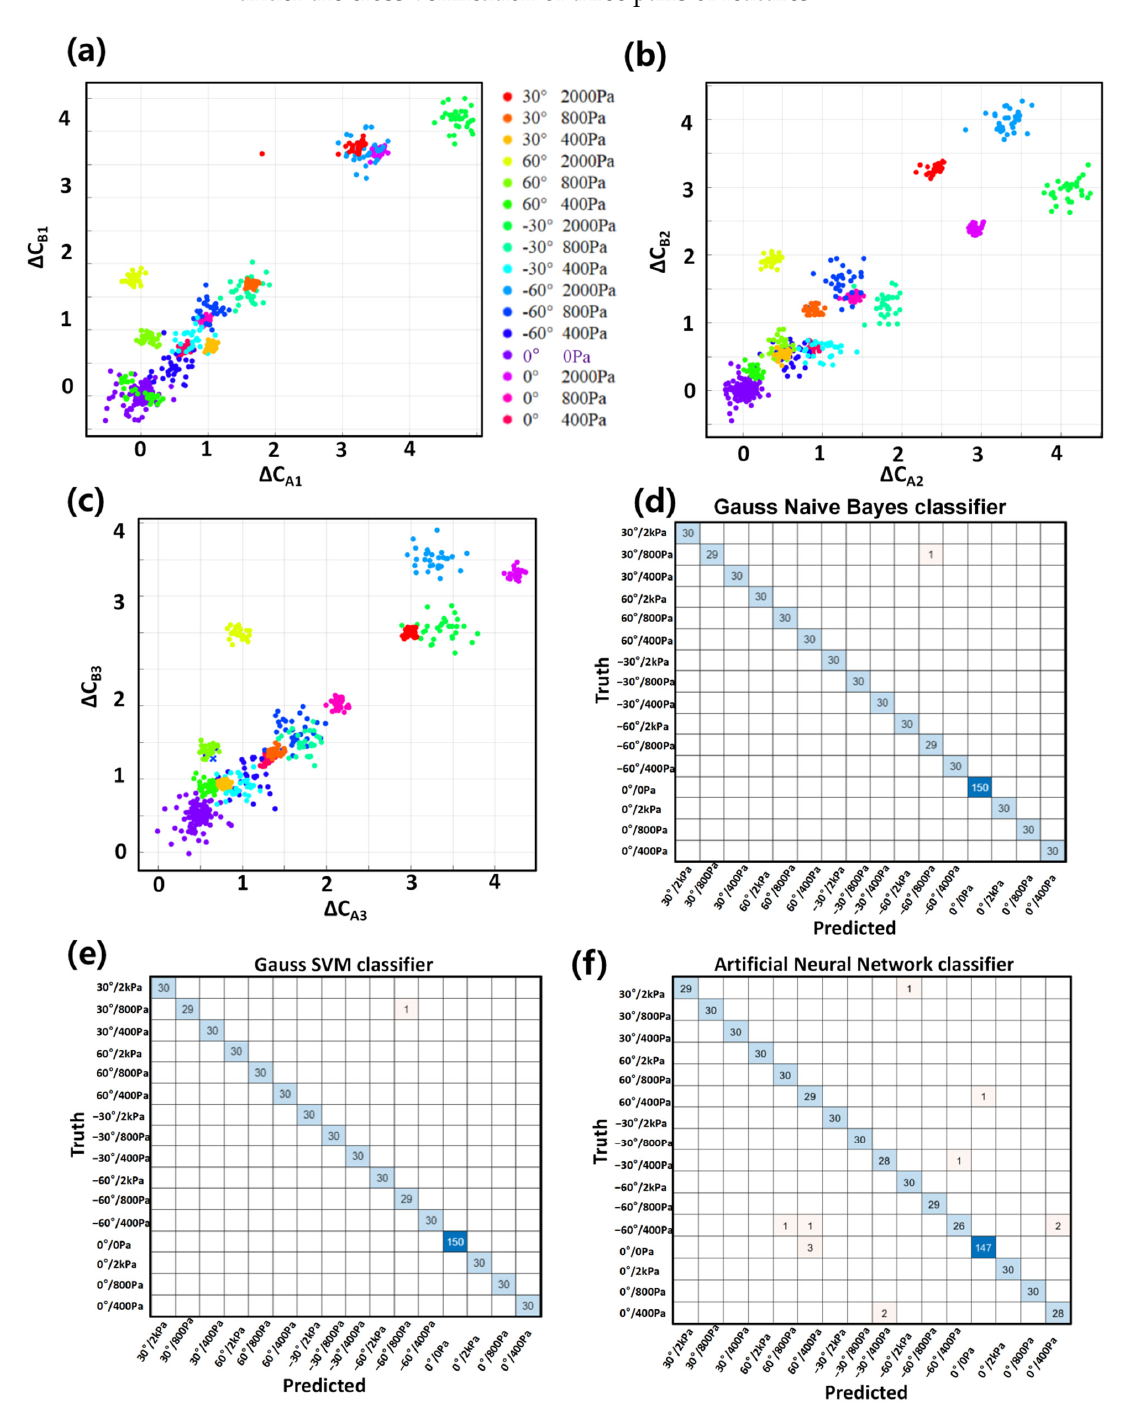
Figure 5. Results of classification methods based on machine learning. ( a – c ) Six channels of data from above mentioned six electrodes in Figure 4a, which were characterized in pair with their relatively variable. ( d ) The machine learning recognition result is based on the Naive Bayes classifier, which has a high accuracy of 99.83%. ( e ) The machine learning recognition result is based on the Gauss SVM classifier, which also has a 99.83% accuracy. ( f ) The machine learning recognition results are based on the Artificial Neural Network classifier, which has slightly lower accuracy (98%).